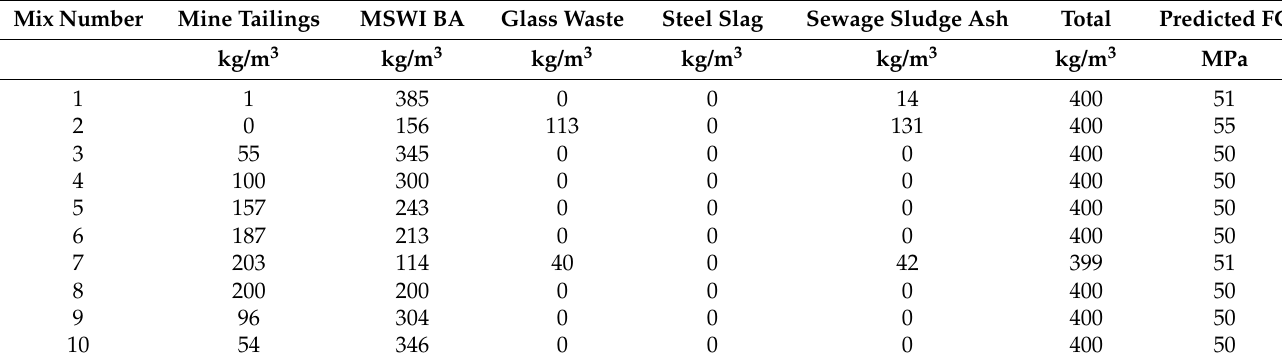
Table 4. Selected optimal mixes using only alternative precursors in